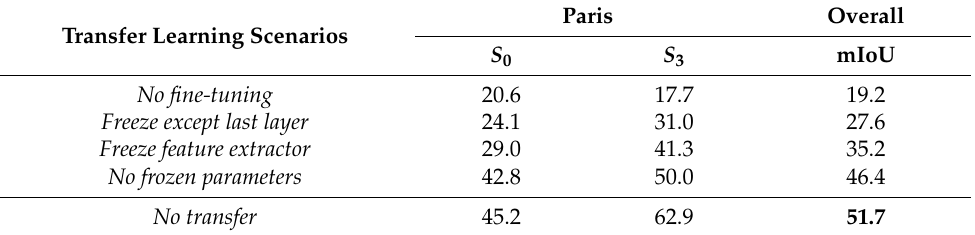
Table 4. Results in transfer learning for the semantic segmentation task using KPConv architecture on our PC3D dataset. Results are mIoU in %. Pre-training was done using urban towns from CARLA ( T 2 , T 3 , and T 5 ). No fine-tuning : the model was pre-trained on CARLA data without fine-tuning on Paris data. No frozen parameters : the model was pre-trained on CARLA without frozen parameters during fine-tuning on Paris data. No transfer : the model was trained only on the Paris training set. Transfer Learning Scenarios